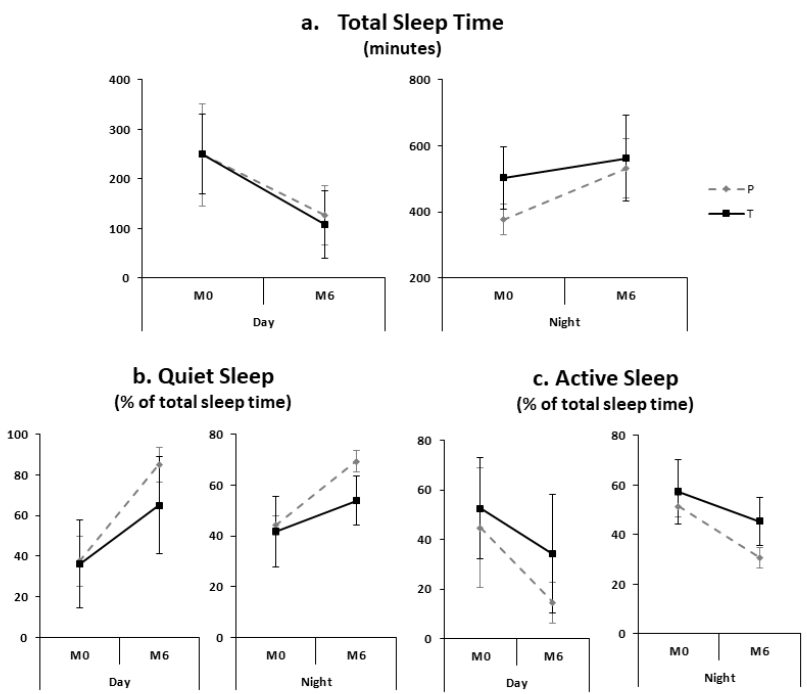
Figure 1. Sleep maturation during day and night sleep in preterm (dotted lines) and term (solid lines) infants.